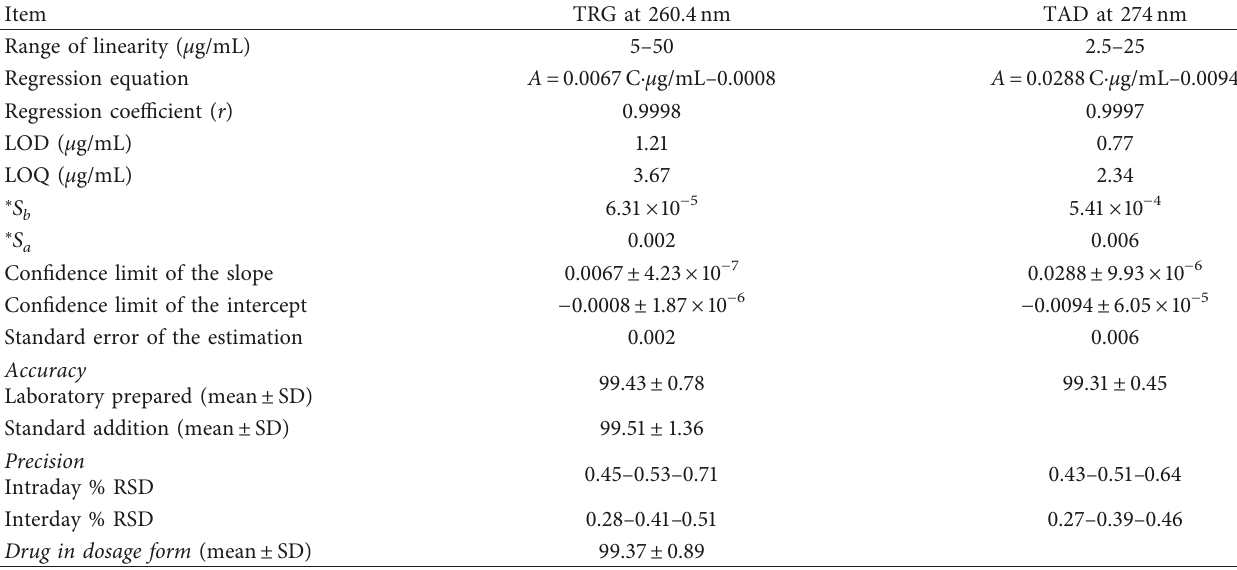
Figure 4: Overlay of the first-order spectra of TRG (5, 10, 20, 30, 40, and 50 µ g/mL) (a) and TAD (2.5, 5, 10, 15, 20, and 25 µ g/mL) (b), using methanol as a blank. Table 2: Results obtained by the proposed first-derivative spectrophotometric method for determination of TRG and